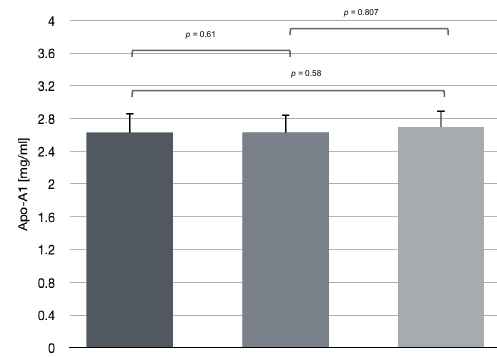
Figure 1. Serum concentration of selected